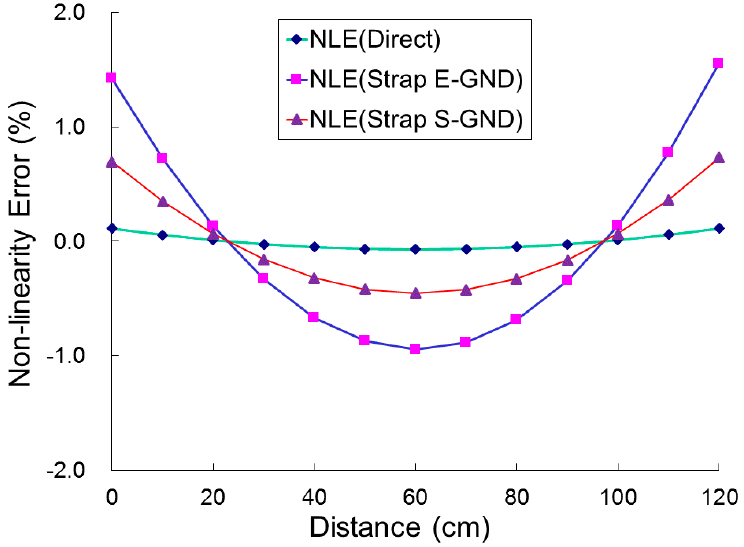
Figure 14. Measured nonlinearity errors ( NLE ) in categories 1, 2, and 3, against the distance, from 0 to 120 cm in steps of 10 cm, for the proposed strip MAGFET with a readout circuit and an IA PCB (INA333).